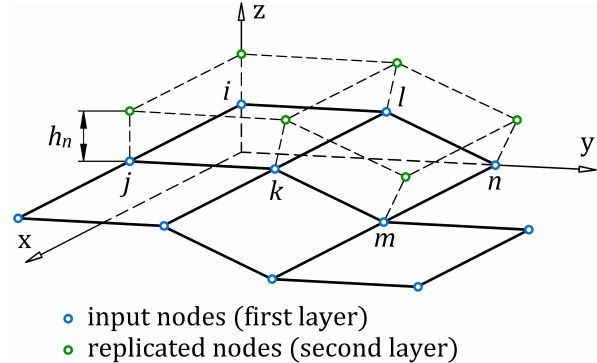
Figure 3: Surface model consisting of five finite elements.